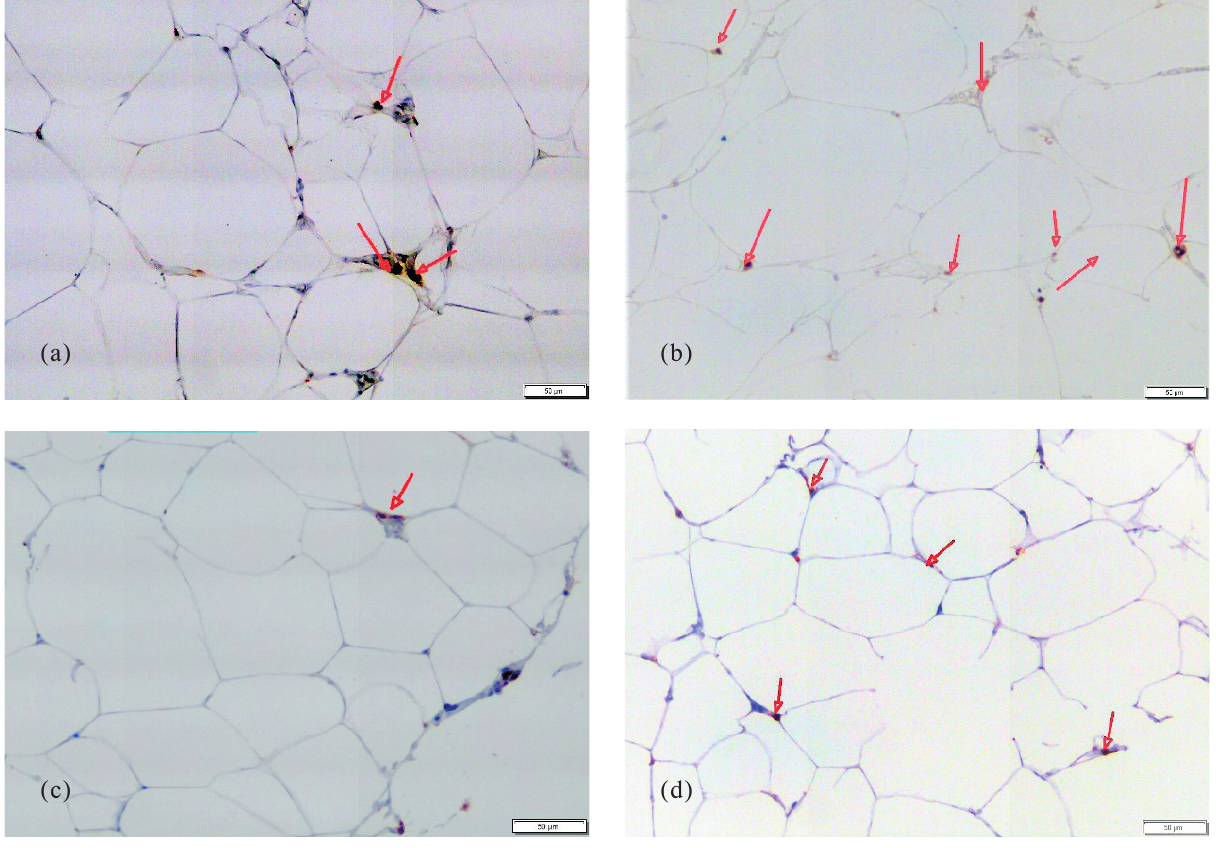
Fig. 3. White adipose tissue in patients with diabetes: (a) subcutaneous white adipose tissue (20×), (b) visceral white adipose tis- sue (20×). Immunohistochemical staining CD68, (c) subcutaneous white adipose tissue (20×), (d) visceral white adipose tissue (20×). Immunohistochemical staining CD204. The arrows indicate the